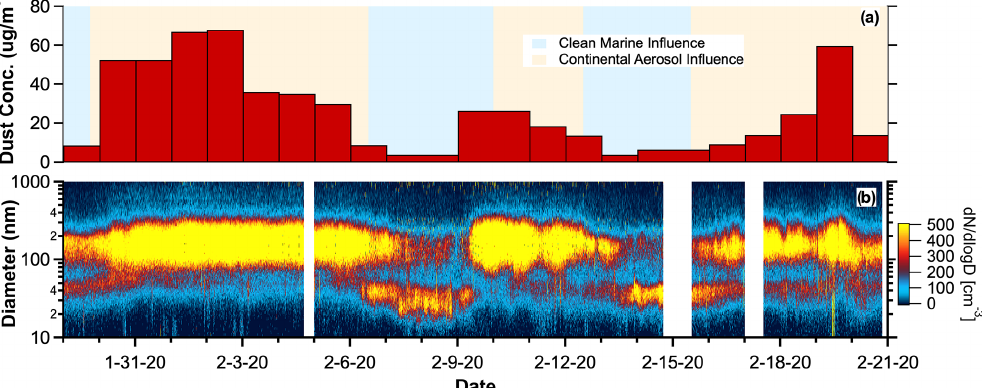
Figure 2. Temporal evolution of (a) dust mass concentrations determined from bulk aerosol filter samples and (b) submicron aerosol particle size distributions determined with an SMPS. Time for both plots is given in UTC ( − 4h local Atlantic Standard Time). Color shading in panel (a) represents continental aerosol influence (orange shading) and clean marine influence (blue shading) (b) as determined by NOAA HYSPLIT back trajectories calculated at Ragged